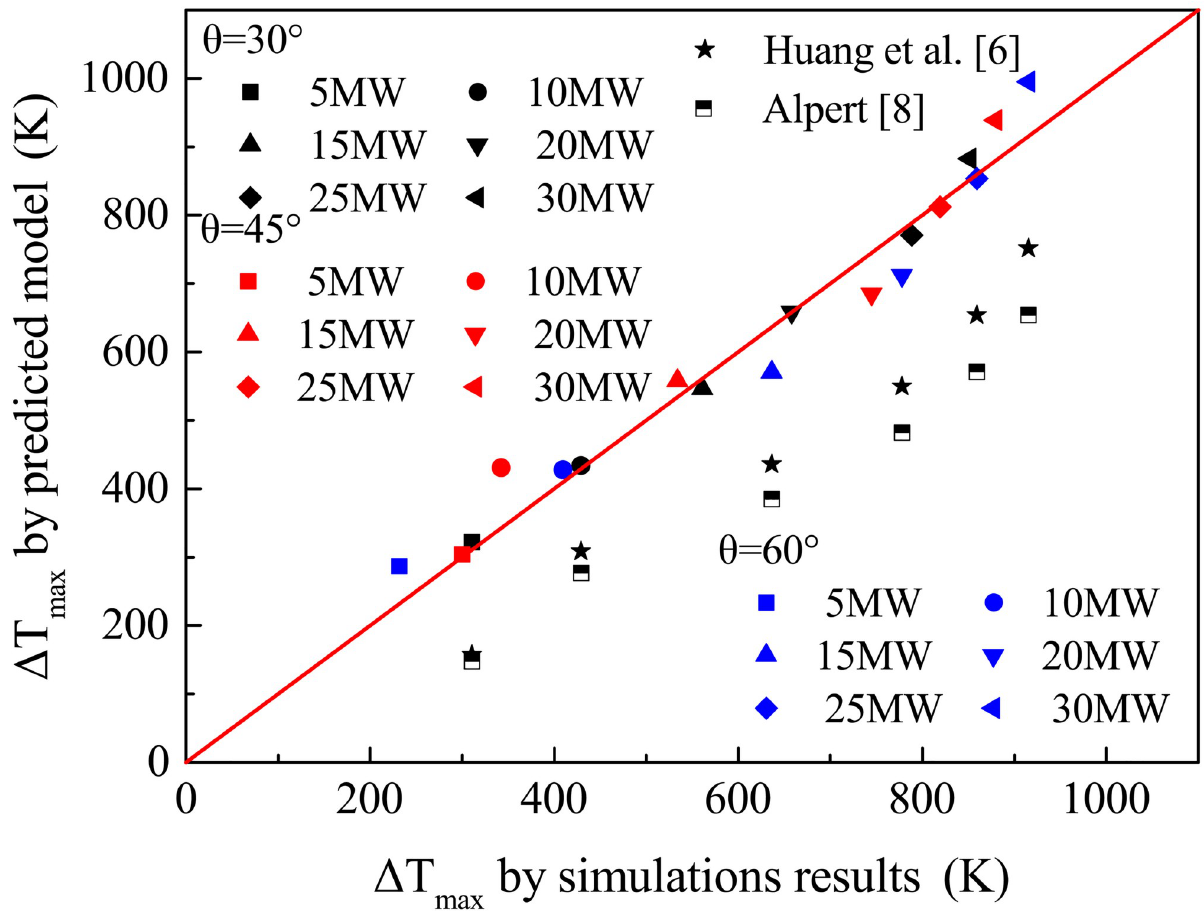
Fig 10. Δ T max obtained by simulations and calculated by